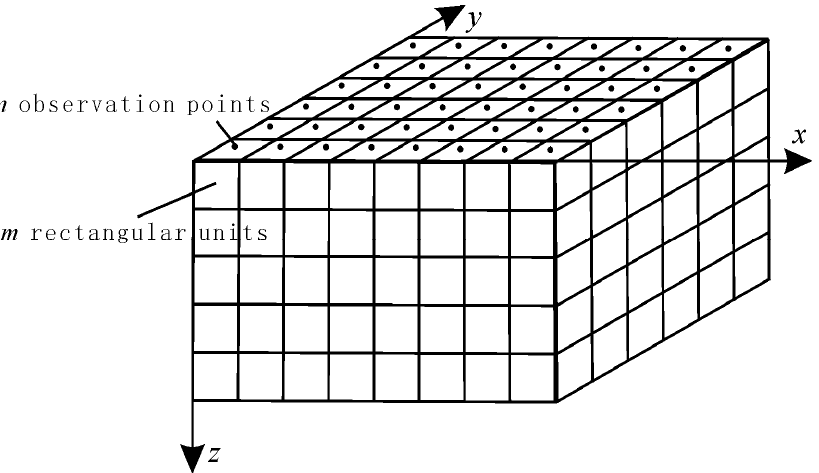
Figure 1. Discretization of underground space.